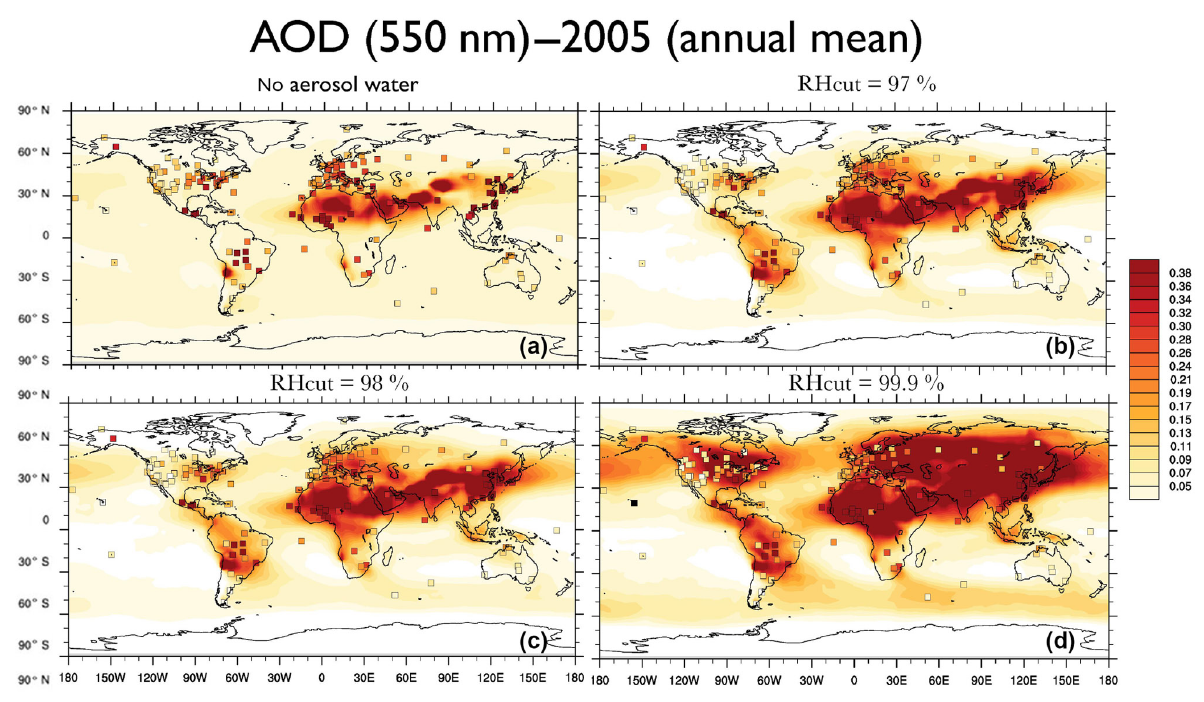
Figure 15. Sensitivity of EMAC AOD to different RH cutoffs (see Sect. 4.3).